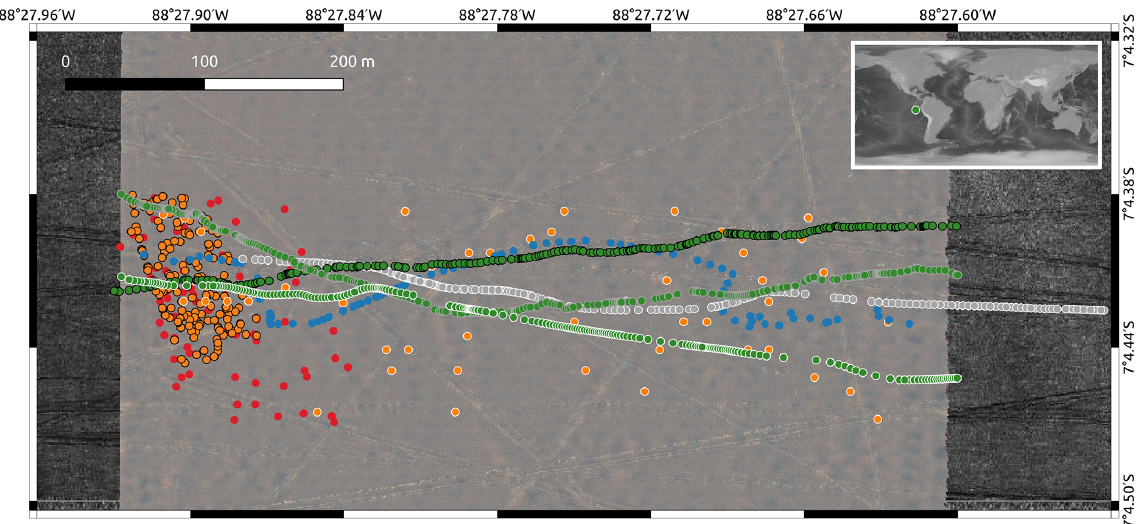
Figure 1. Overview map of imaging locations of the eight different datasets. DS A (green dots, grey border), DS B (green dots, black border), DS C (blue dots), DS D (green dots, white border), DS E (orange dots, black border), DS F (grey dots), DS G (orange dots, white border) and DS H (red dots). The world map in the top right corner shows the geographical location of the DISCOL area in the eastern South Pacific (green dot; © NOAA, Amante and Eakins, 2009). The study area covers ca. 600m × 150m. The background map shows another photo mosaic, created from the full image set of which DS G is a subset. Criss-crossing lines are plough tracks by the mining simulation in